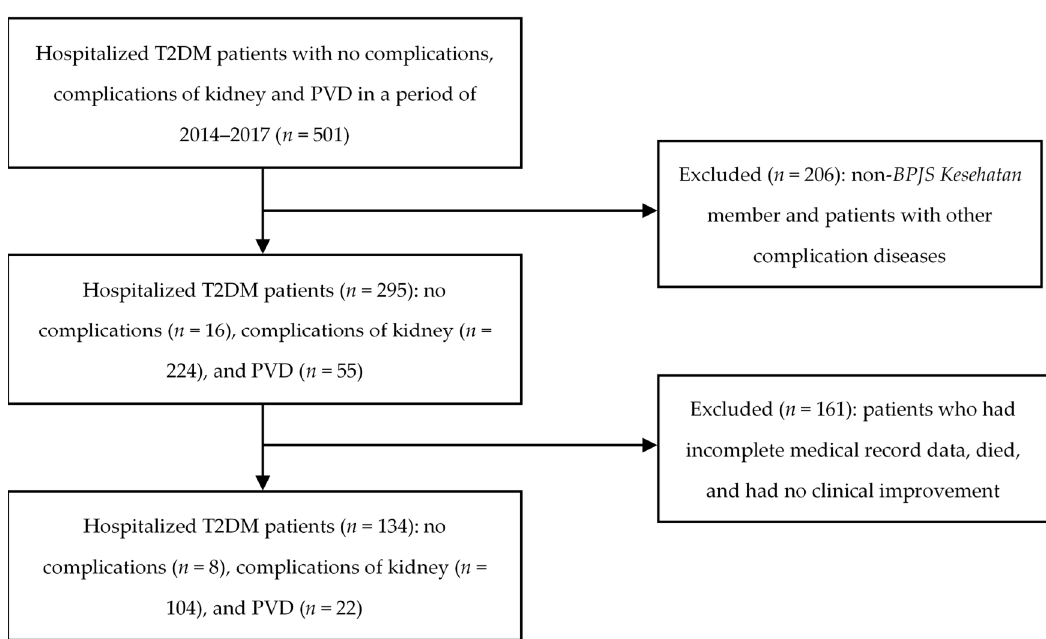
Figure 1. Flowchart of patient